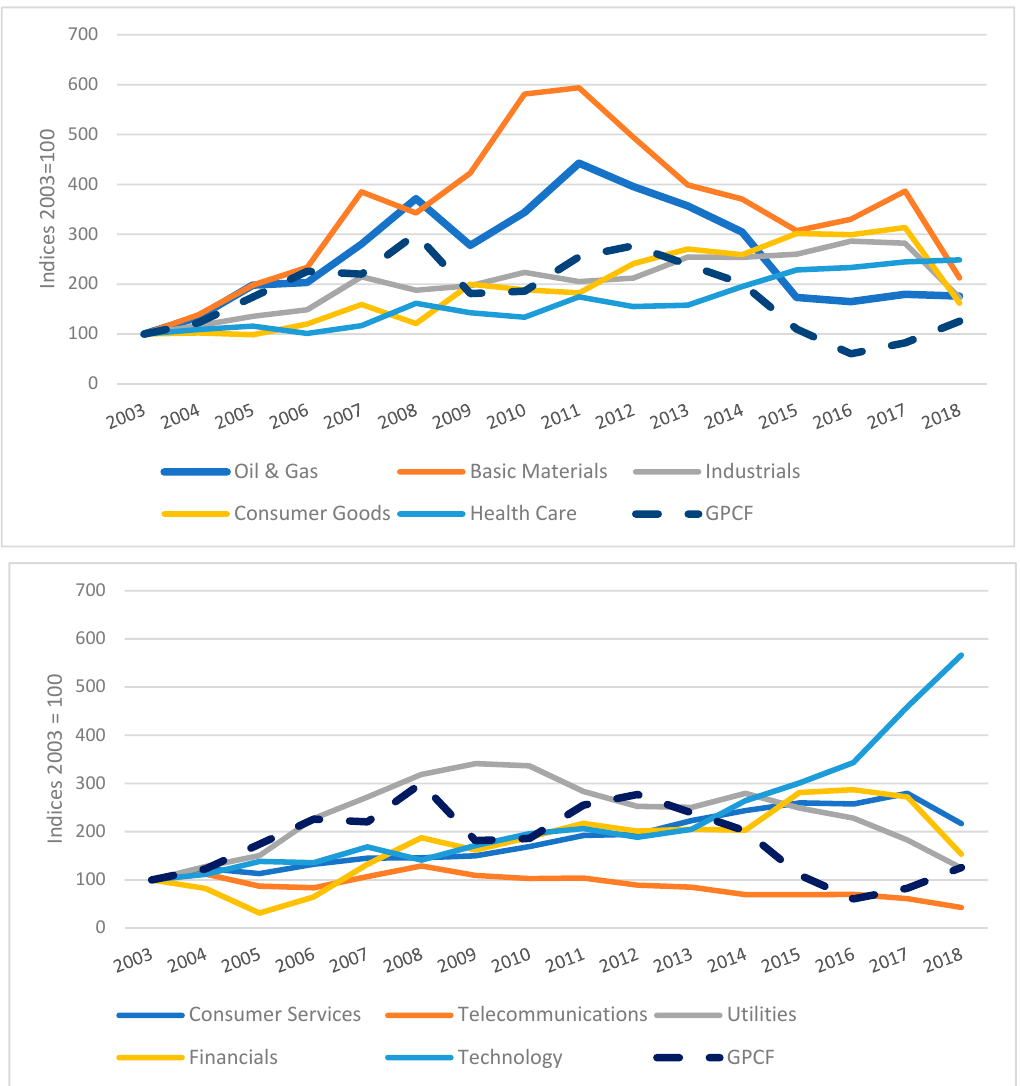
Figure 2. Time series of weighted operating cash flows for each of the ICB industries as well as the Norwegian government’s cash flow from petroleum activities (GPCF), indexed,